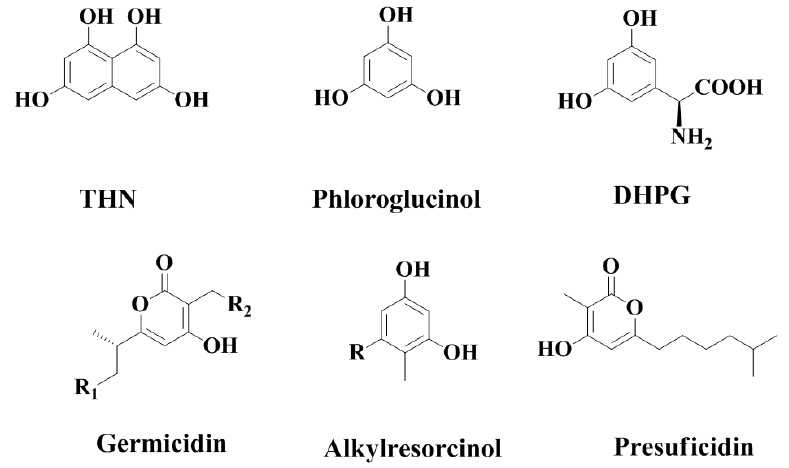
Figure 1. Chemical structures of major bacterial type III polyketide synthase (PKS) products.